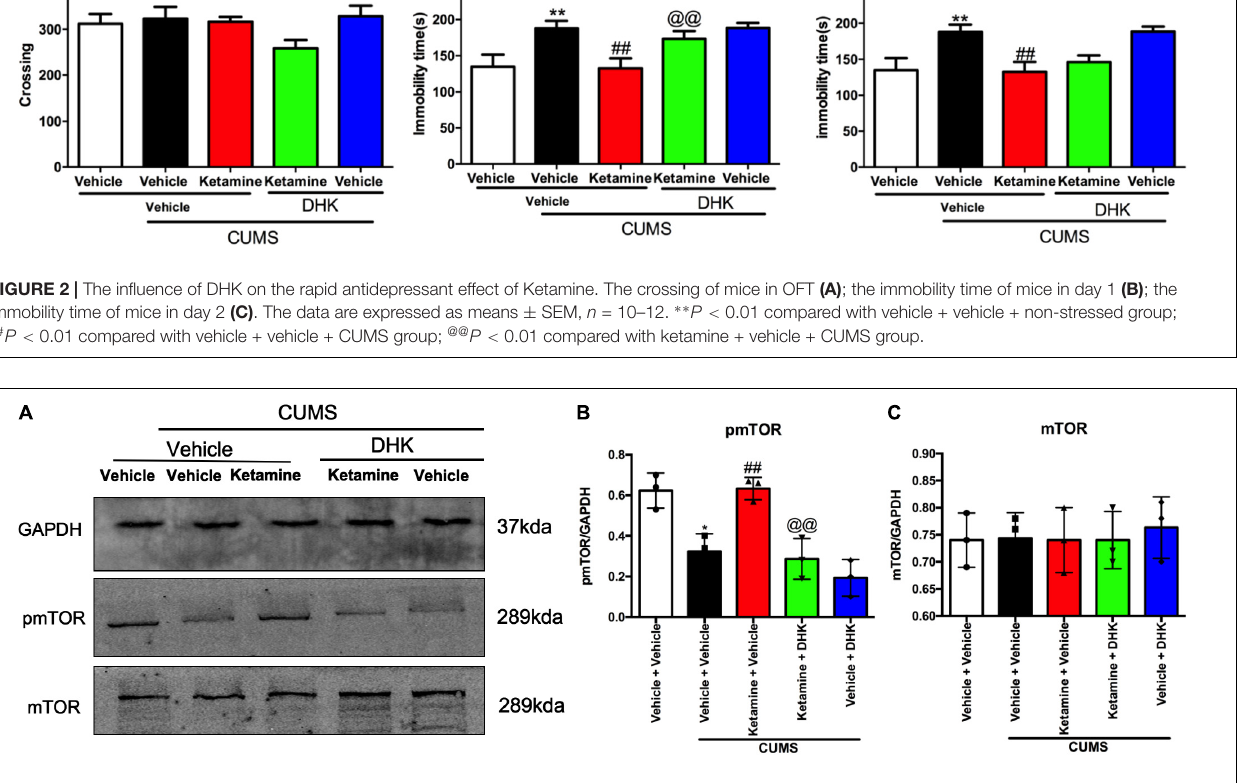
FIGURE 3 | The influence of DHK on the mTOR phosphorylation in the PFC of mice. mTOR and pmTOR protein expression were determined by Western blot. Representative western blot (A) and quantification (B,C) of fold changes in the protein levels of pmTOR and mTOR in the PFC of mice. The data are expressed as means ± SEM; n = 3; * P < 0.05 compared with vehicle + vehicle + non-stressed group; ## P < 0.01 compared with vehicle + vehicle + CUMS group; @@ P < 0.01 compared with ketamine + vehicle + CUMS